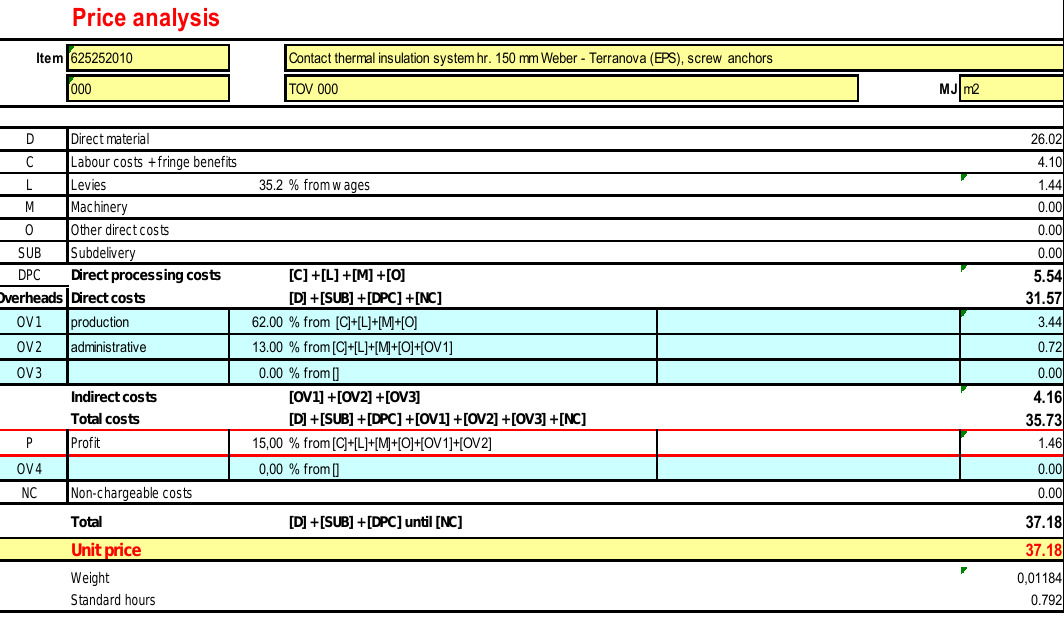
Figure 3. Calculated profit according to the Unified Calculation Formula (UCF) methodology. The aggregate margin rate (Figure 4) (levies + PO + CO + Profit) from the base of Direct Wages for the calculation of the indicative prices 2016/I is 148.00%.